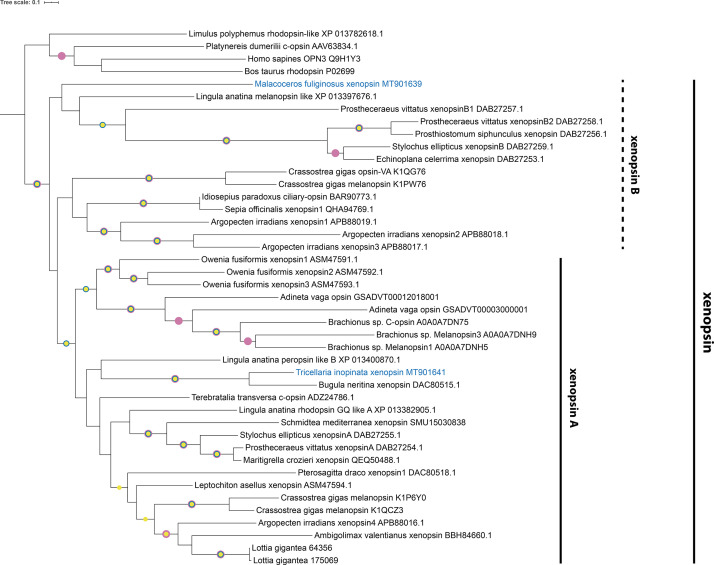
Xenopsin tree rooted with few c-opsins.Maximum Likelihood analysis (IQ-TREE, LG+F+I+G4). Labeled nodes have support values of approximate Bayes test ≥0.98 (yellow dot), SH-like approximate likelihood ratio test ≥90 (blue dot), and ultrafast bootstrap ≥90 (purple dot). The sequences investigated in this study are highlighted in blue.